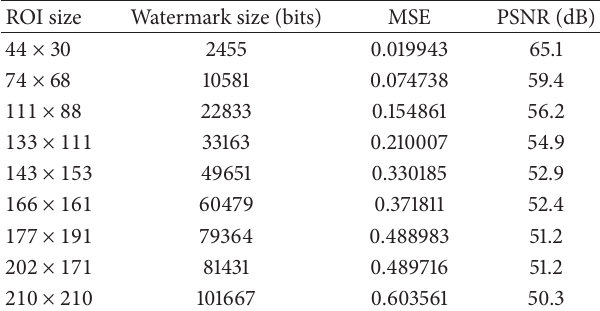
Table 4: Embedding performance of CT scan image of size 512 ×